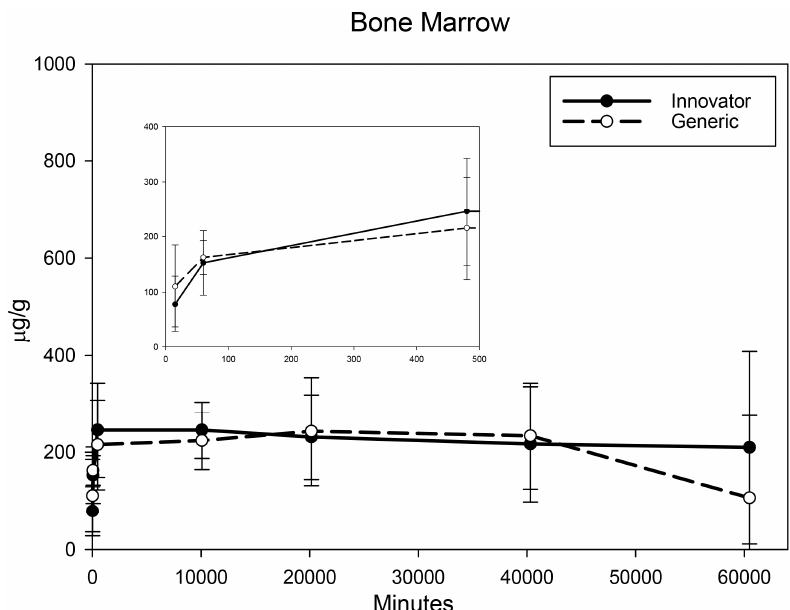
Figure 2. Bone marrow mean iron concentrations over time. Endogenous (control) iron concentration was subtracted from both the innovator (solid) and the generic (dashed). Negative results are not graphed. Time points = 15 min, 60 min (1 h), 480 min (8 h), 10,080 min (1 week), 20,160 min (2 weeks), 40,320 min (4 weeks), 60,480 min (6 weeks). Inset shows the first three time points (15 min, 1 h, 8 h). Values are shown as mean + SD; n = 6 per group per time point.